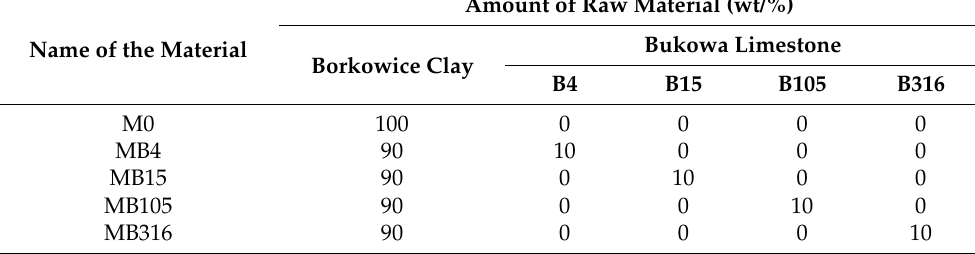
Table 3. Composition of ceramic